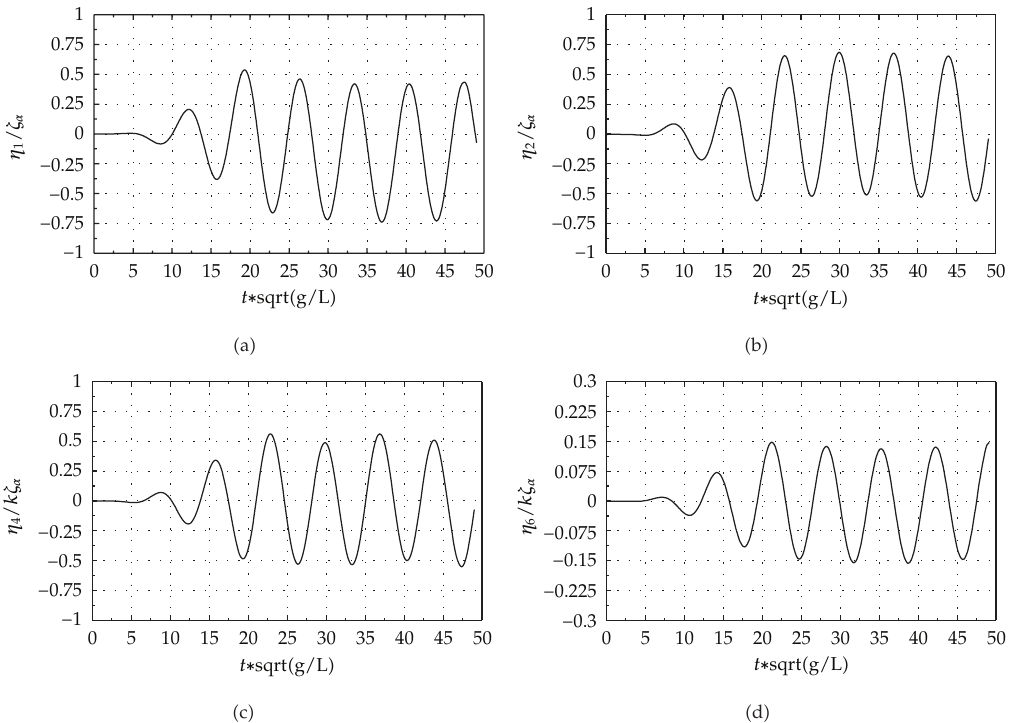
Figure 7: Calculated time histories of surge, sway, roll, and yaw motions; T (cid:7) 3s, χ (cid:7) 135 ◦ .